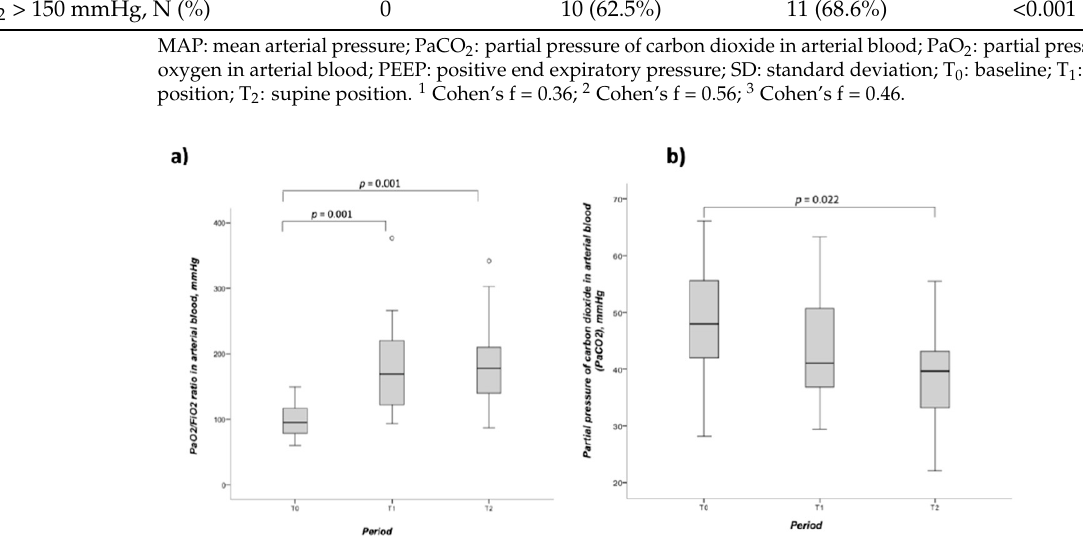
Figure 2. Arterial blood gas measures at baseline (T0), prone position (T1), and supine position (T2) in pregnant women with SARS-CoV-2 induced ARDS: ( a ) PaO 2 /FiO 2 ratio; ( b ) PaCO 2 . Abbreviations: paCO 2 : partial pressure of carbon dioxide in arterial blood; paO 2 : partial pressure of oxygen in arterial blood; FiO 2 : inspired oxygen fraction. (Tukey’s post-hoc test). There was no difference in PaCO 2 or PaO 2 /FiO 2 ratio observed when prone and su- pine positions were compared. There was no association between PP and a decrease in mean arterial pressure (MAP, p = 0.986) or an increase in the prevalence of norepinephrine administration ( p = 0.933). There were no cases of ventilation-associated pneumonia or pulmonary thromboembolism over two weeks after PP. 4. Discussion To date, this is the largest study investigating cases involving PP in pregnant patients with ARDS. We verified that PP is a safe and effective procedure in women on mechanical ventilation due to severe ARDS who were in the second- and third-trimester of pregnancy. Furthermore, we achieved favorable obstetric outcomes in the very critically ill group of patients. Nearly one-third of our patients left the ICU without delivering. The literature regarding PP during pregnancy is scarce and comprises reports of PP feasibility and successful cases [2,3,7–9,12–14]. In our study, in addition to verifying the feasibility of a PP protocol in pregnant women with moderate to severe ARDS, we as- sessed the effectiveness of the procedure by verifying significant sustained improvements in PaO 2 /FiO 2 ratio and PCO 2 values after PP. These favorable outcomes may have contrib- uted to delayed deliveries in severe ARDS patients undergoing PP. There are multiple mechanisms by which the prone position contributes to improved oxygenation including increasing the homogeneity of ventilation and perfusion of the entire lung, relieving alveolar compression in the dorsal lung regions, and changing chest compli- ance, which improves the distribution of gases toward the ventral and para-diaphragmatic lungs. The impact of PP persists after the patient returns to a supine position [2,15]. A PaO 2 /FiO 2 ratio < 150 mmHg is a classical indication for PP. During and after PP, 62.5% and 68.7% of patients presented with PaO 2 /FiO 2 > 150 mmHg, which is a treatment target when managing patients with ARDS. From another point of view, an increase greater than 20% in PaO 2 /FiO 2 ratio indicates a patient is a responder to PP [16]. All pa- tients in the present study were classified as responders during PP, and half of them sus- tained this response after placement in the supine position. Criteria indicating responders or non-responders are not clearly related to mortality improvement, although literature findings on the subject are controversial [1,17–20]. Nonetheless, improvements may have contributed to the delayed preterm delivery in severe ARDS observed in this study.